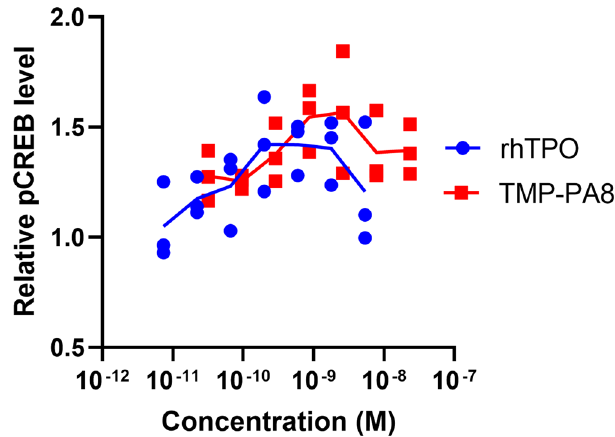
Fig. 5 Bioactivity evaluation of the TPO mimetic STaMPtide. Signaling potencies induced by TMP-PA8. Starved HEL cells were stimulated by TMP-PA8 (red squares) or rhTPO (blue circles) for 10 min. Relative phosphorylation levels of CREB were evaluated by phospho-CREB ELISA. The mean and individual values are shown from the results of triplicate